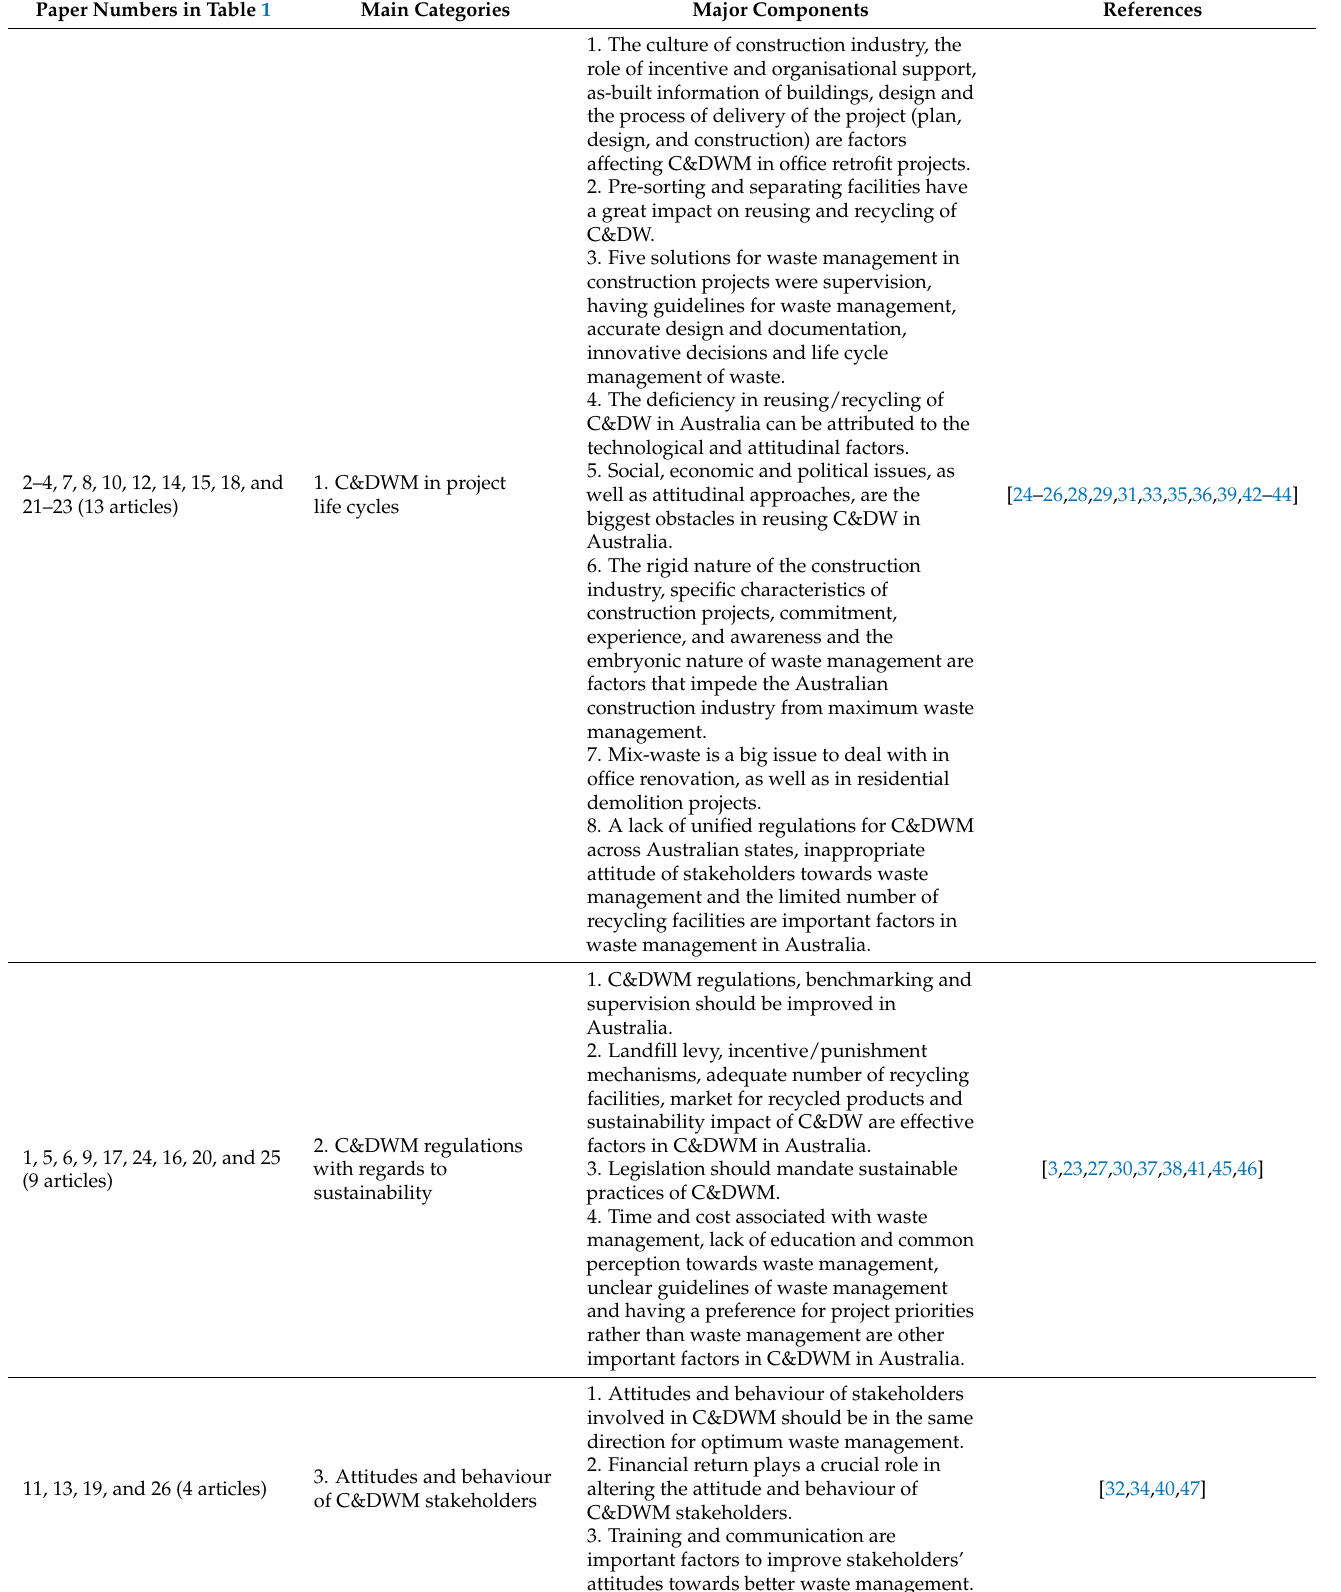
Table 3. Factors contributing to construction and demolition waste management in